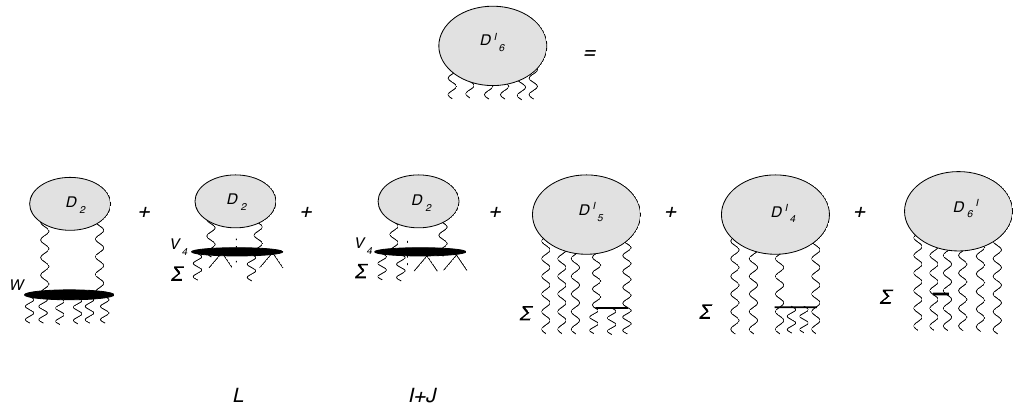
with 6 reggeized gluons. In the terms 6